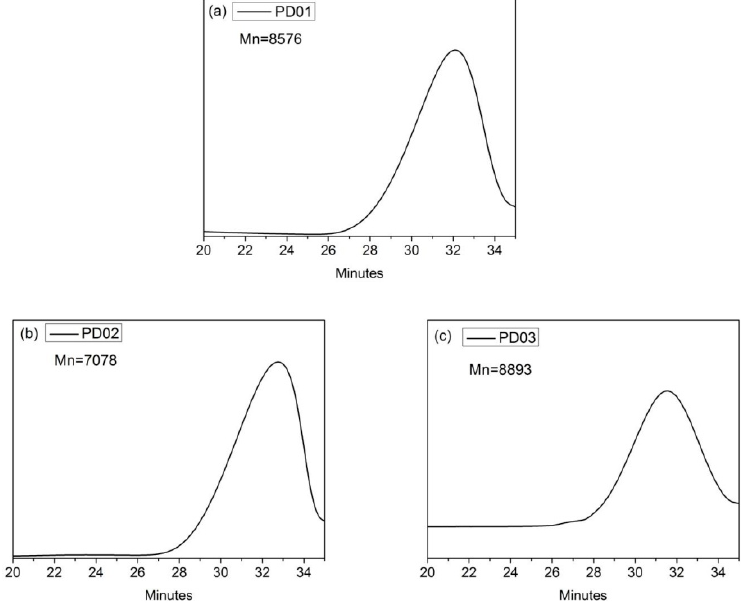
Figure 5. The GPC spectra and Mn of dispersants: ( a ) PD01; ( b ) PD02; ( c ) PD03. Table 3. Molecular weights and yields of dispersants PD0x.